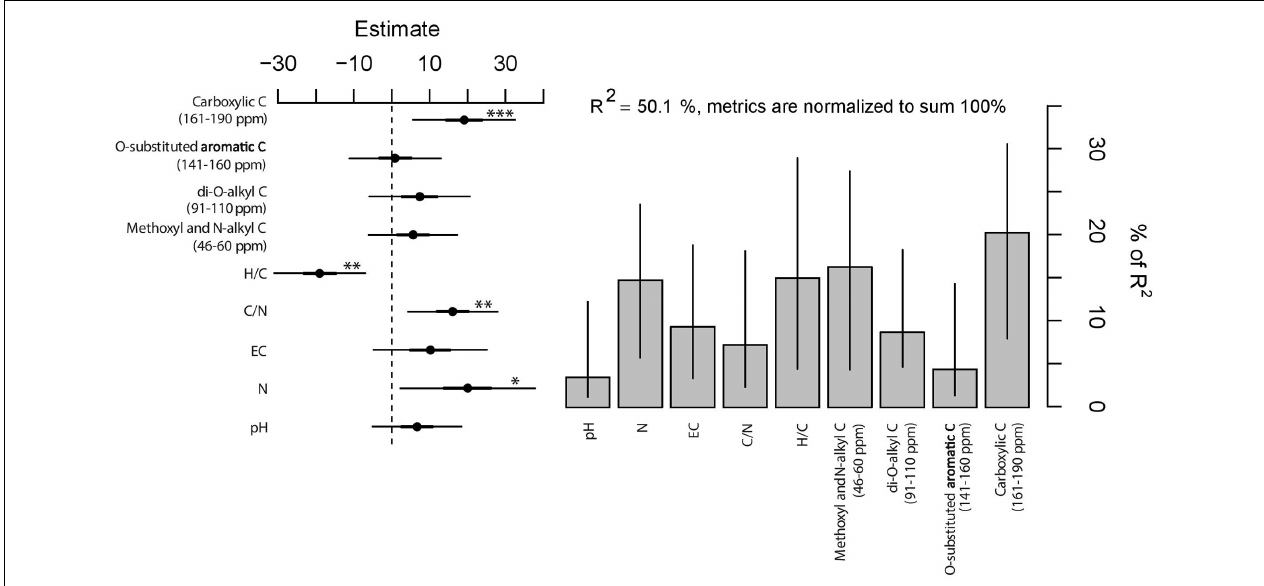
FIGURE 5 | Estimates (filled circles) and 95% confidence interval (bars) of linear regression (left panel). ∗∗∗ , ∗∗ , and ∗ indicate significance for P < 0.001, P < 0.01, and P < 0.05, respectively. Right panel shows the relative importance ( y -axis, percentage of variance explained) of predictors with the bootstrapped 95% confidence interval